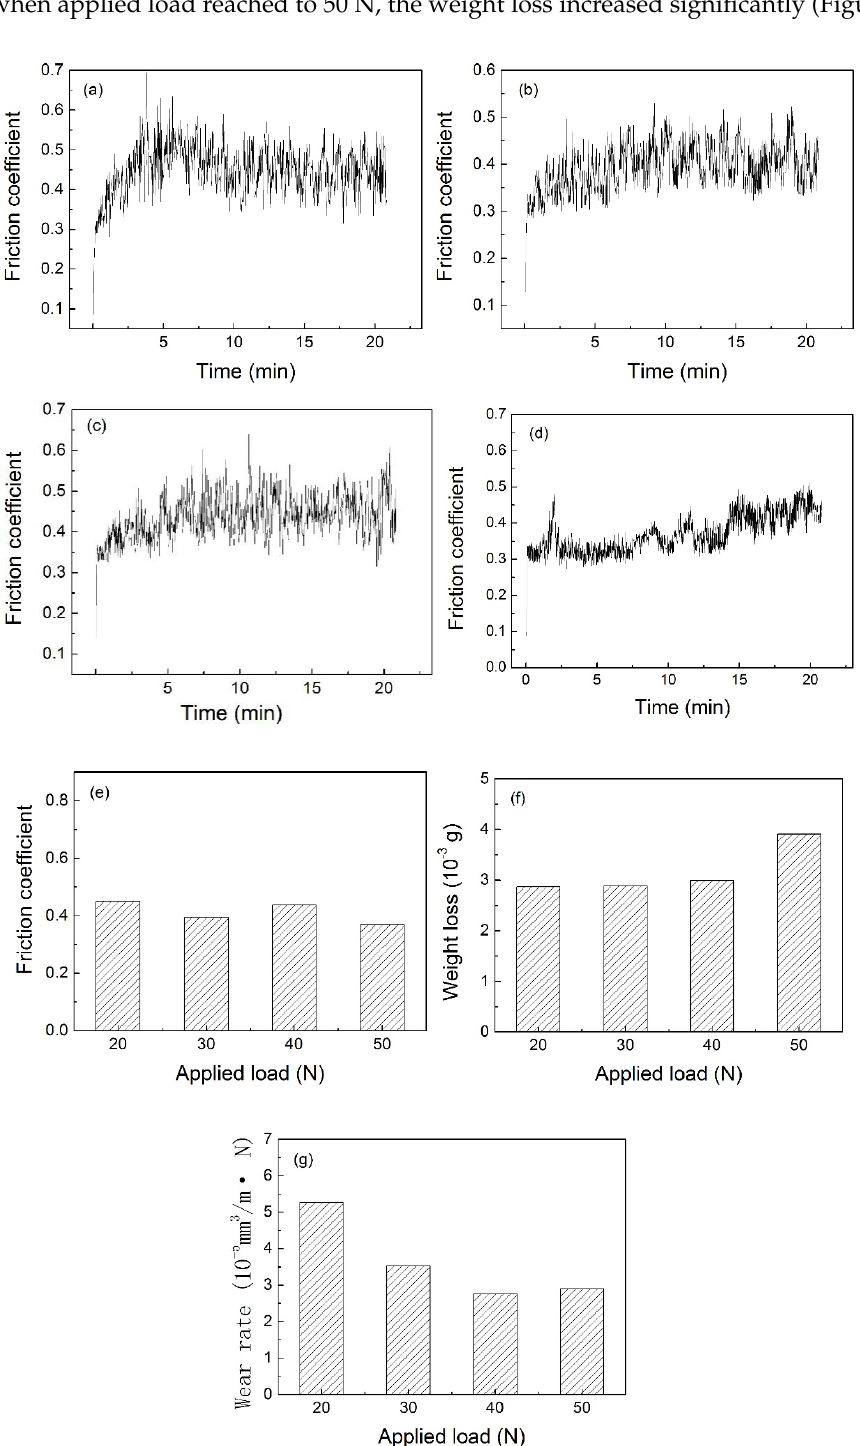
Figure 7. Friction coefficient, weight loss and wear rate of the rheoformed composite parts at different applied load: ( a ) friction coefficient at 20 N, ( b ) friction coefficient at 30 N, ( c ) friction coefficient at 40N, ( d ) friction coefficient at 50N, ( e ) average friction coefficient, ( f ) weight loss and ( g ) wear rate.